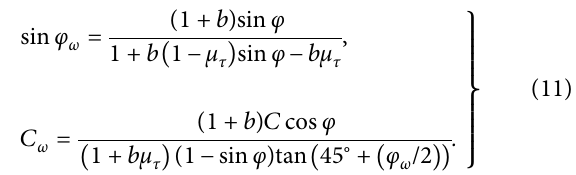
Figure 4: Mohr–Coulomb criterion.